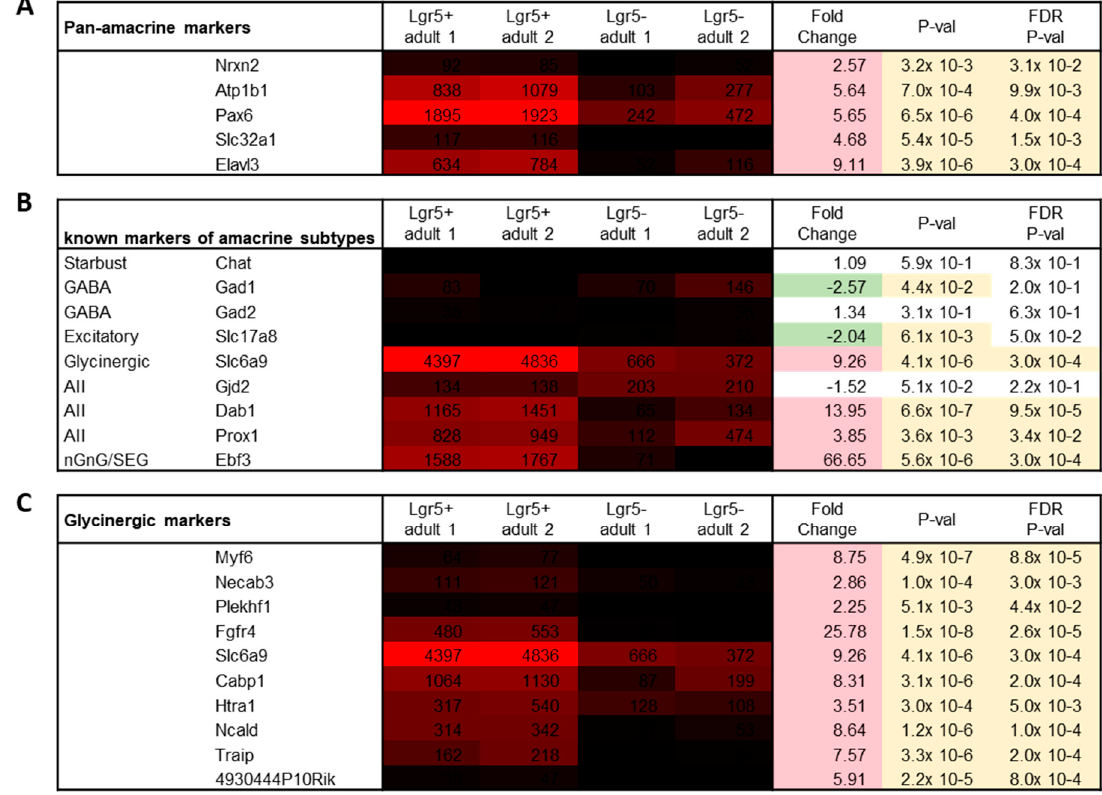
Figure 4. Gene expression levels and fold changes of amacrine cell markers in adult tissue. ( A ) Fold change shows higher expression of all pan-amacrine markers in adult Lgr5 + compared to Lgr5 − cells, ( B ) Slc6a9 marking glycinergic cells is the highest expressed of all known makers of amacrine subtypes, and ( C ) besides Slc6a9, other markers of glycinergic amacrine cells are also expressed in Lgr5 + cells. Differentially expressed genes were defined by a fold change ≥ 2 or ≤ − 2, p -value < 0.0, and false discovery rate (FDR) < 0.05.